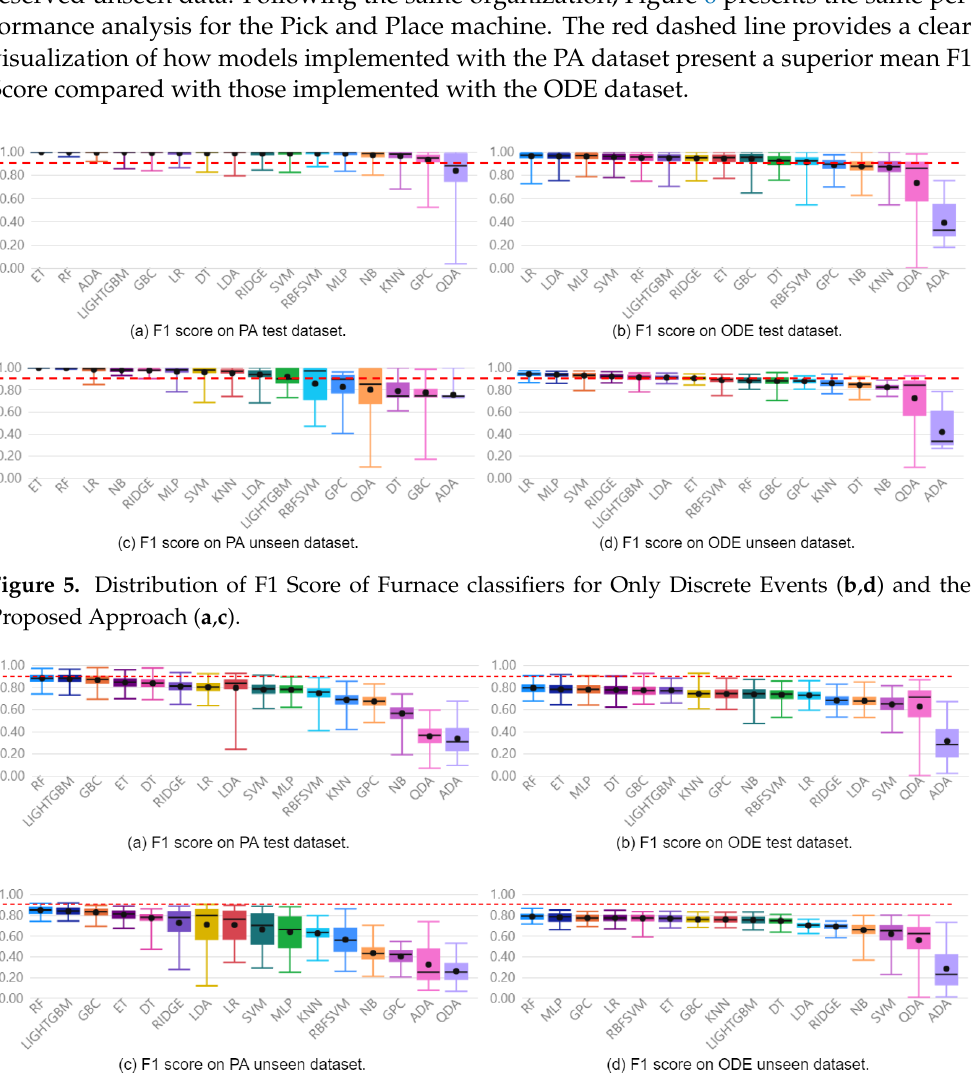
Figure 6. Distribution of F1 Score of Pick And Place